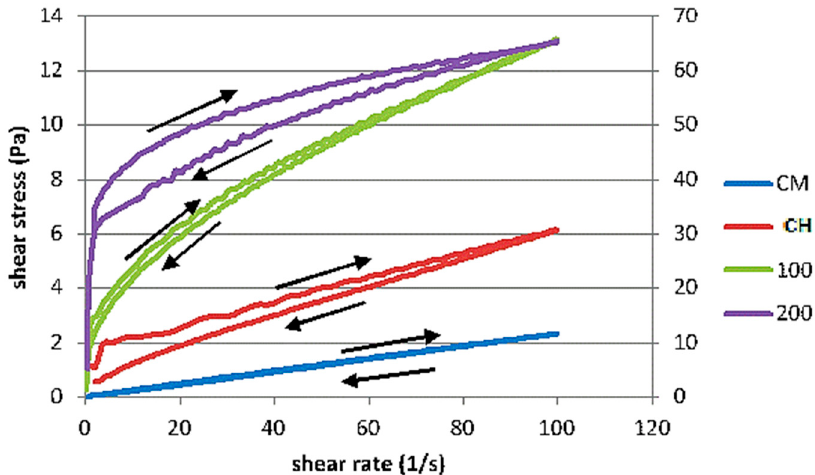
Figure 3. Hysteresis loops for O/W emulsions containing 50% oil and WPI 4% stabilized by CM (blue line), CH at 15 MPa (red line) and by UHPH at 100 MPa (green line) and 200 MPa (purple line).